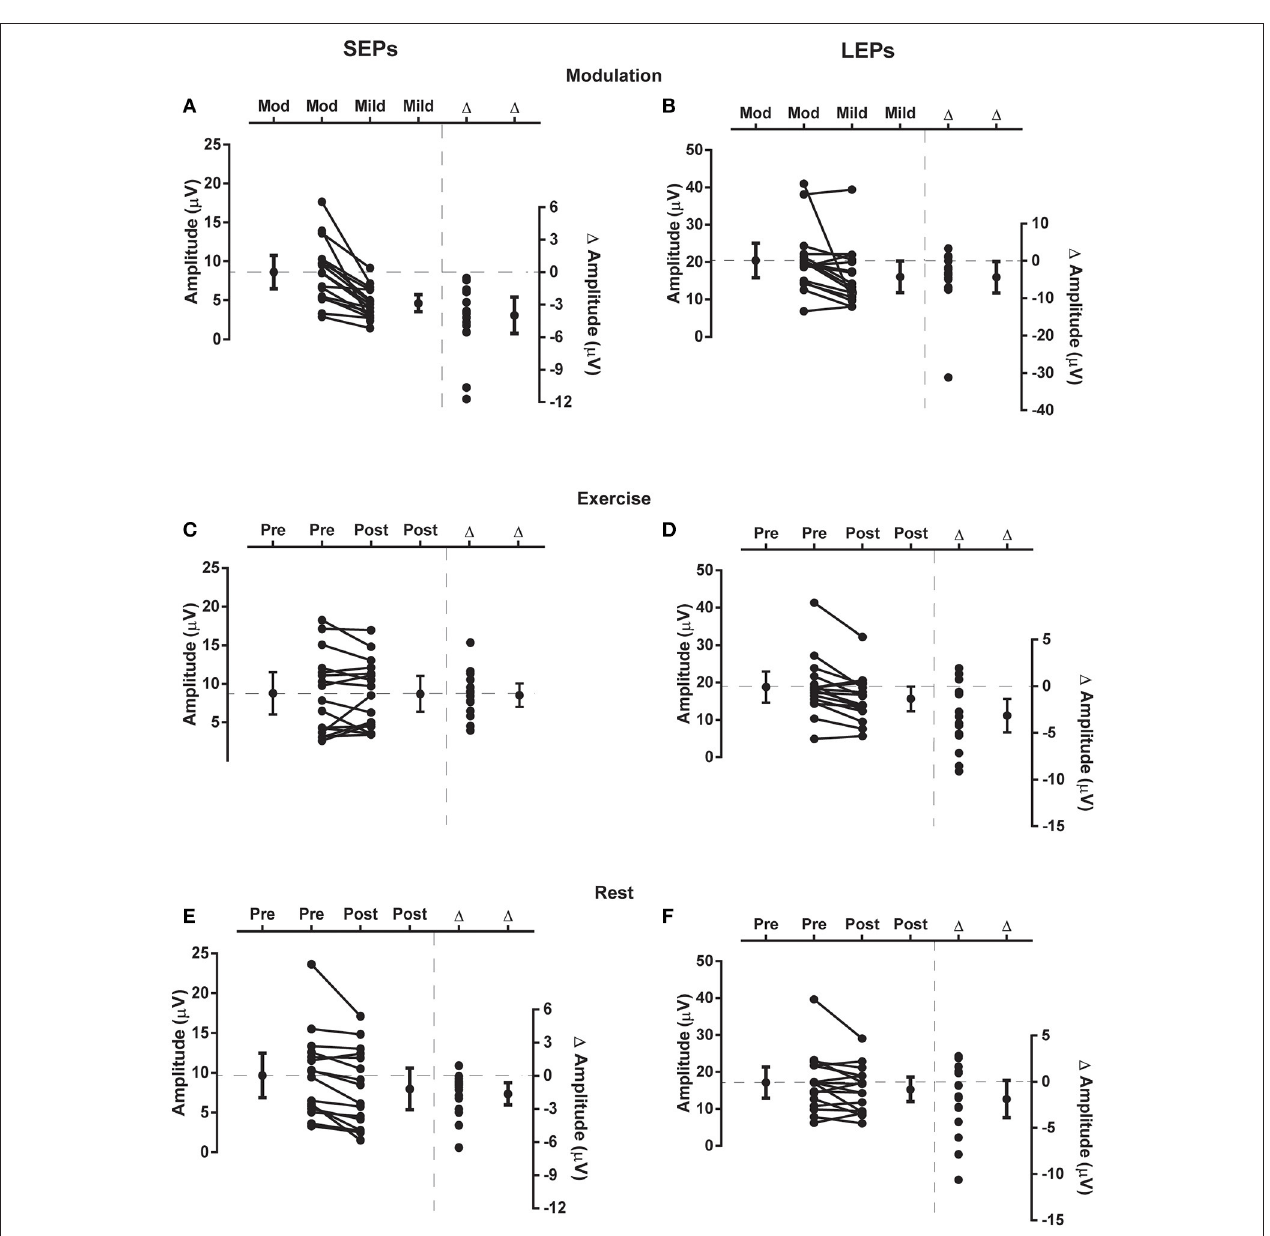
FIGURE 4 | Changes in evoked potential N2P2 amplitude. Each panel presents individual and group data (mean and 95% confidence interval) for the N2P2 evoked potential amplitude to the left side of vertical dashed line and individual and group differences ( 1 ; mean and 95% confidence interval) in evoked potential amplitude to the right side of vertical dashed line. SEP data from Experiment 1 are in the left panels (SEPs, A,C,E ) and LEP data from Experiment 2 are in the right panels (LEPs, B,D,F ). (A,B) Responses to mild and moderate (mod) pain stimuli recorded in the modulation blocks. (C,D) Responses recorded before (pre) and after (post) exercise. (E,F) Responses recorded before and after a period of rest. In each of these plots the zero-difference level on the right-hand y-axis is aligned to the group mean for the reference condition of moderate stimulation intensity (A,B) , pre-exercise (C,D) or pre-rest (E,F) . Data to the left of the vertical dashed line are plotted against the left-hand y-axis and data to the right of the vertical dashed line are plotted against the right-hand